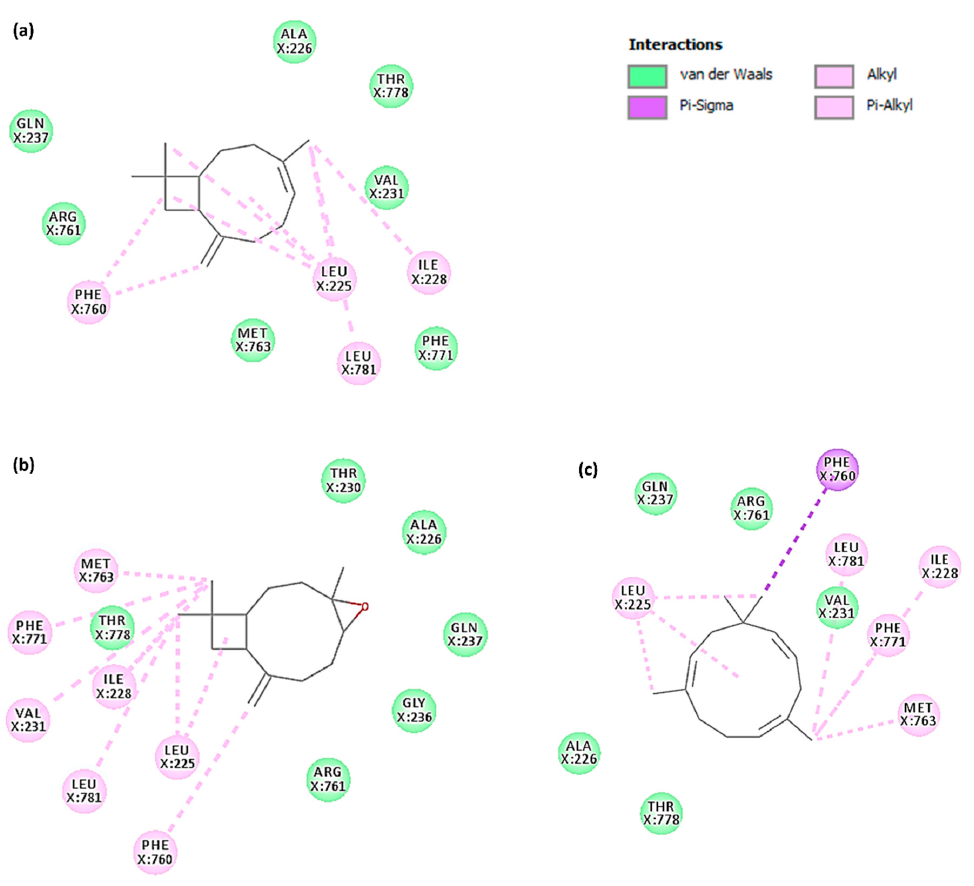
Figure 9. 2D-map of β -caryophyllene ( a ) and β -caryophyllene oxide ( b ), in comparison with the ring-opened isomer α -caryophyllene ( c ), in the binding site of P-gp representing interactive amino acids and types of interactions.